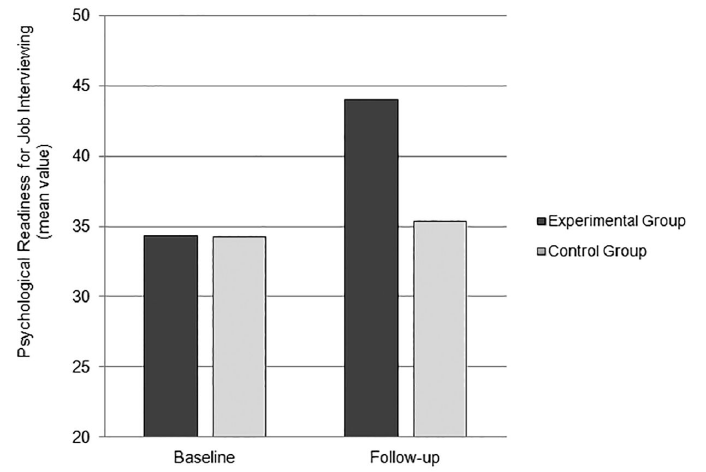
Figure 3. Between-group differences in self-reported psychological readiness for job